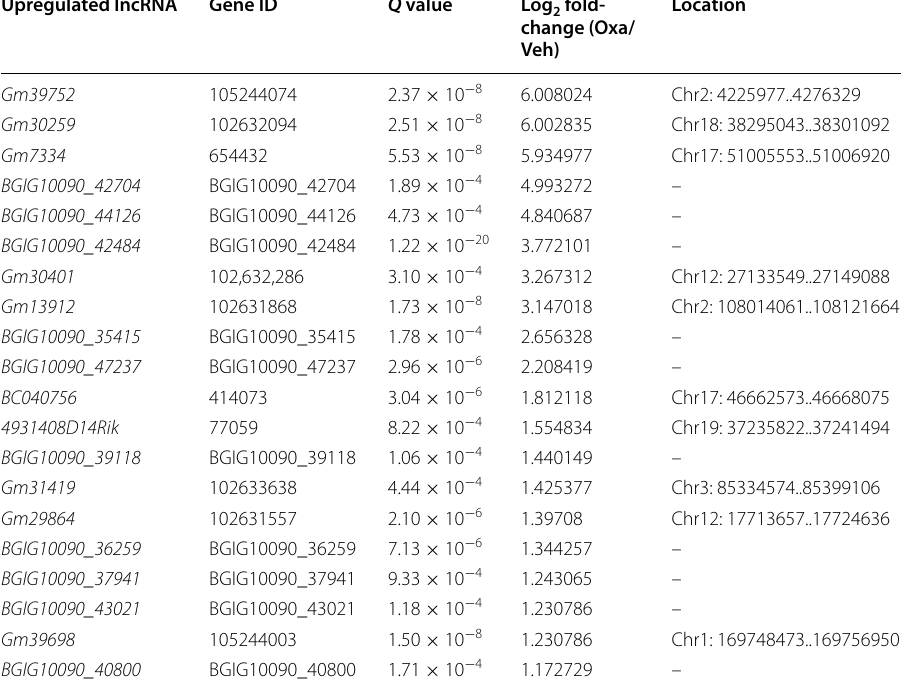
Table 4 Detailed information on the top 20 upregulated DElncRNAs Upregulated lncRNA